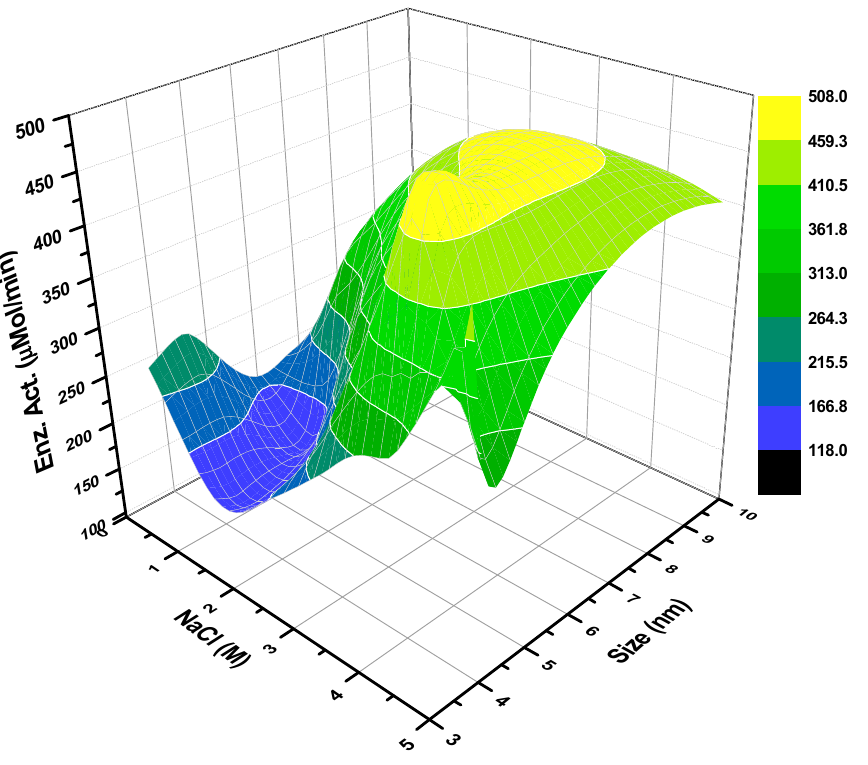
Figure 4. Effect of average size distributions and NaCl variation on the enzymatic activity of AOT/Water/Isooctane reverse micellar systems.